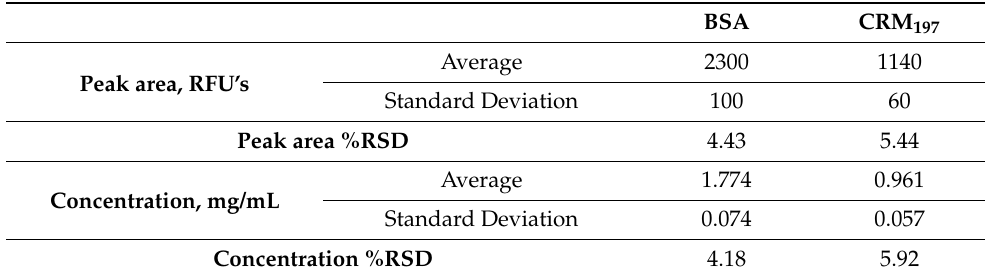
Table 3. Average value, standard deviation and %RSD for BSA and CRM 197 when analyzed